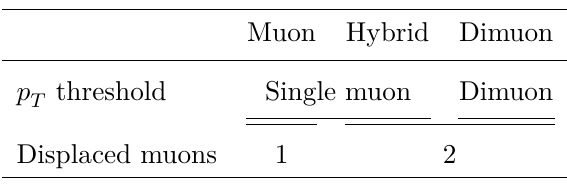
Table 2 : Summary of the number of muons the p of displaced muons in the three trigger scenarios used in this analysis. The single muon and dimuon p thresholds for each of the datasets are given in table T